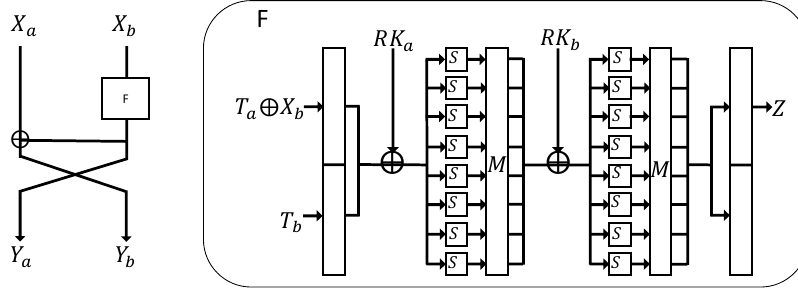
Figure 1. Feistel based round structure of FEA.